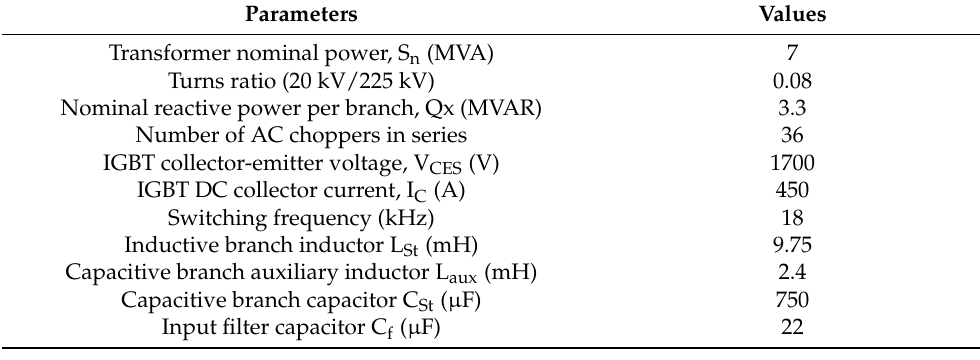
Table 4. Characteristics of the voltage balancer based on the Steinmetz circuit controlled by AC choppers.